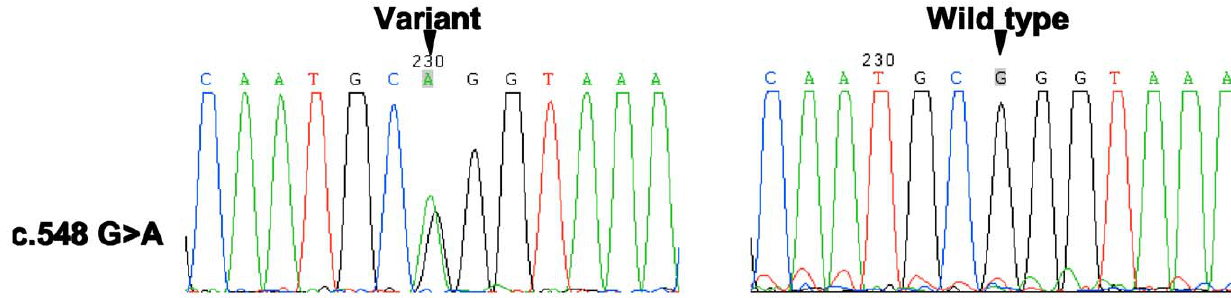
Figure 5. Sequencing chromatograms of novel pathogenic variant (c.548G . A) in this work with control. Arrow: the variant location.